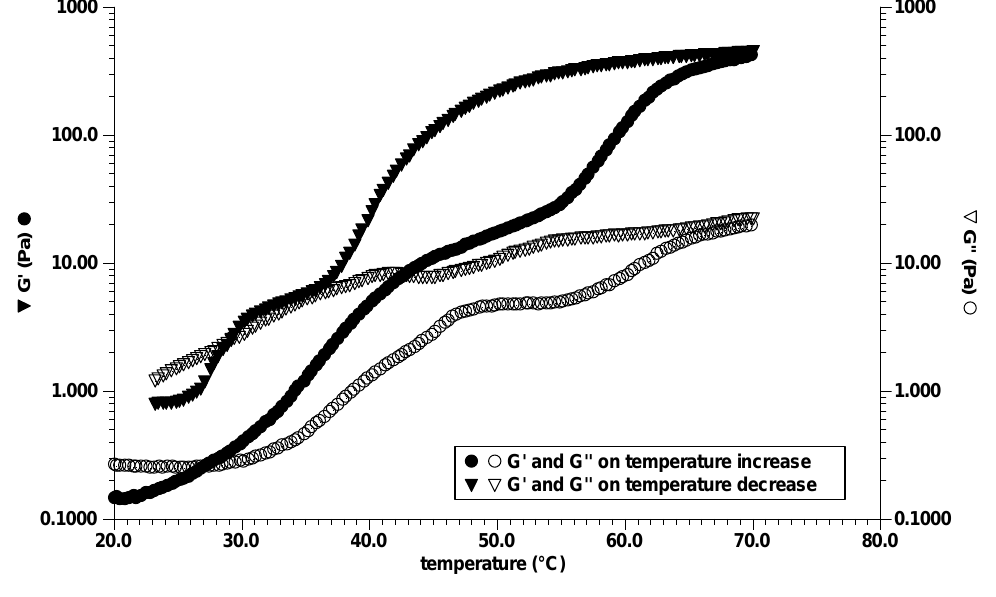
Figure 7. G’ and G’’ at 1 Hz, as a function of the temperature. G’ (  ), G’’ (  ) on temperature increase from 20 to 70 °C; G’ (  ), G’’ (  ) on temperature decrease from 70 to 25 °C. Concentration of initial methylcellulose: 30 g/L in water. Temperature rate is 3 °/mn.